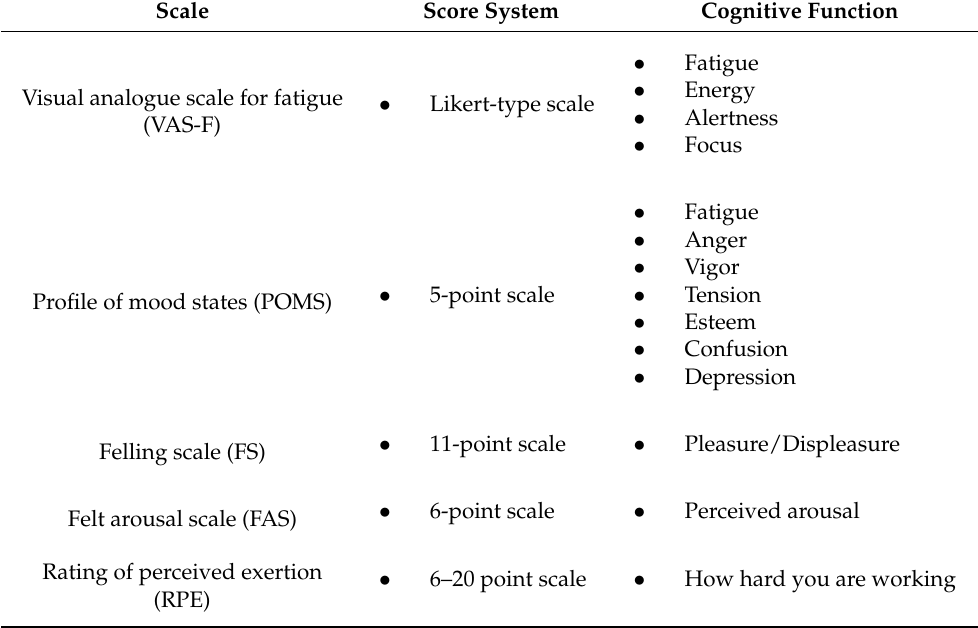
Table 2. Subjective scales and score systems used to measure cognitive